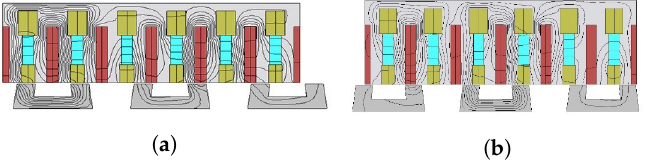
Figure 2. Flux linkage at two different positions. ( a ) Point 1; ( b ) Point